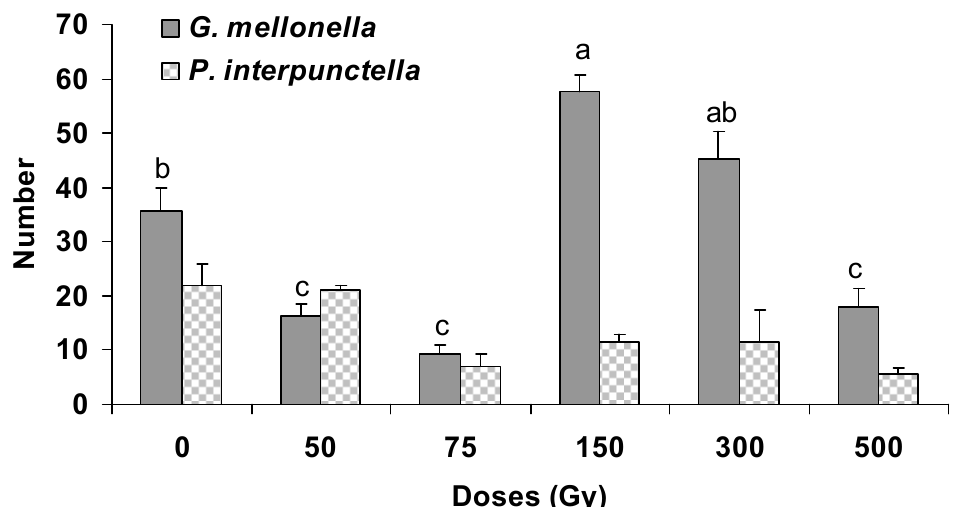
Figure 1. Percentage of parasitism (% ± SE) by H. hebetor developing from the gamma irradiated larvae of G. mellonella and P. interpunctella .